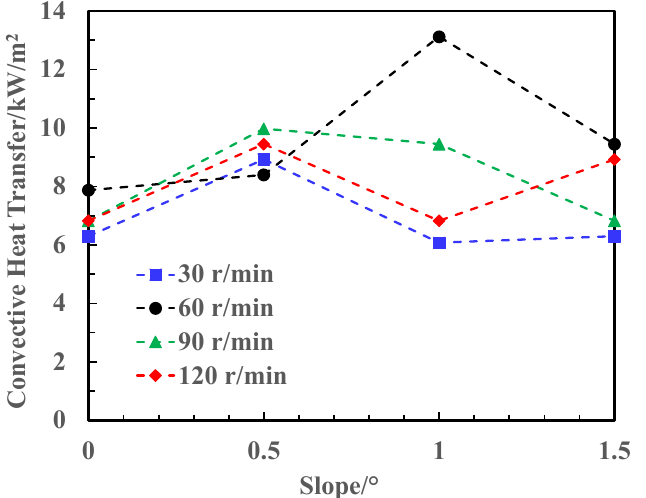
Figure 7. Variation of flow heat transfer of an n-heptane spill fire at the bottom surface with a slope. To measure the flame feedback radiation in the burning process, we configured 4 water-cooled heat flow meters at the bottom of the glass. Since the thickness of an oil layer is very thin during a spill fire burning, it can be assumed that most of the feedback radiation passes through the oil layer and the glass bottom, with only a small part being absorbed by the oil layer and glass bottom. The heat flow meter measures the radiant heat loss through the oil layer and the glass bottom. These measurements are shown in Figure 8.